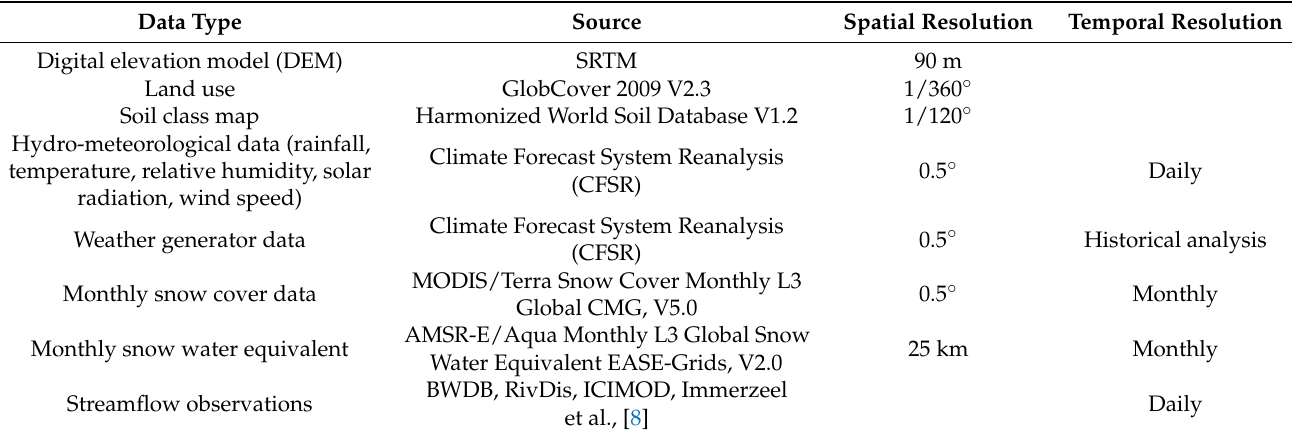
Figure 3. Land cover and soil map of the Brahmaputra Basin. Map source: Authors. Table 1. Model input data and